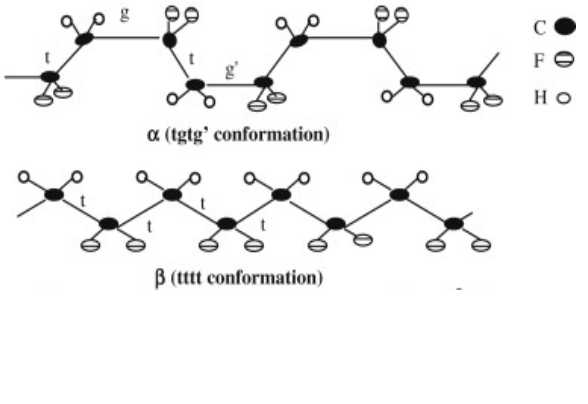
Figure 3. Conformation of PVDF α - and β -phase (Reprinted with permission from [64]. Copyright 2009 Elsevier).